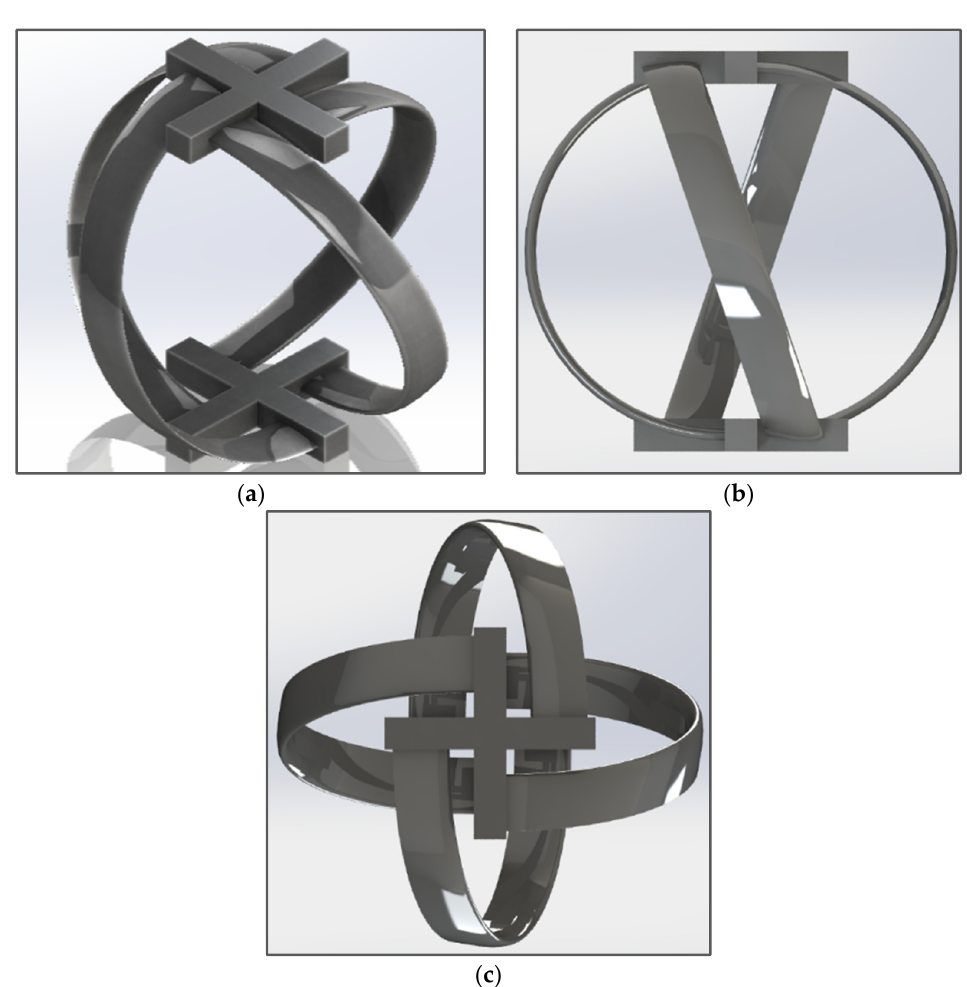
Figure 9. ( a ) Oblique view of the turbine geometry; ( b ) front view of the turbine geometry; ( c ) top view of the turbine geometry.